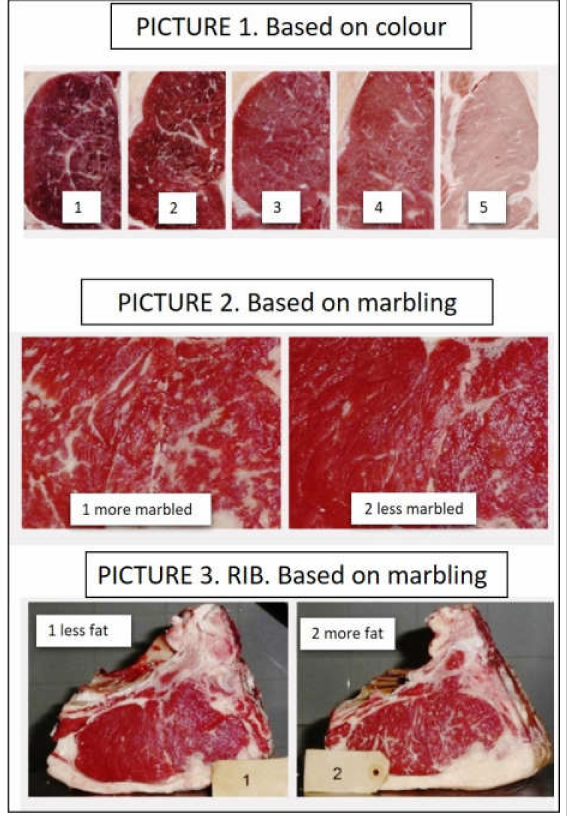
Figure A1. Pictures used in the